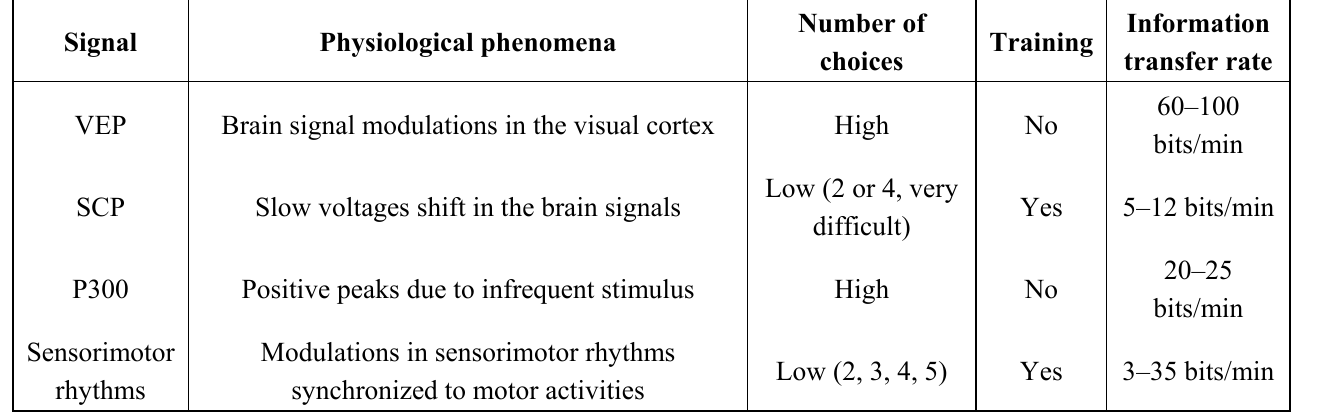
Table 2. Summary of control